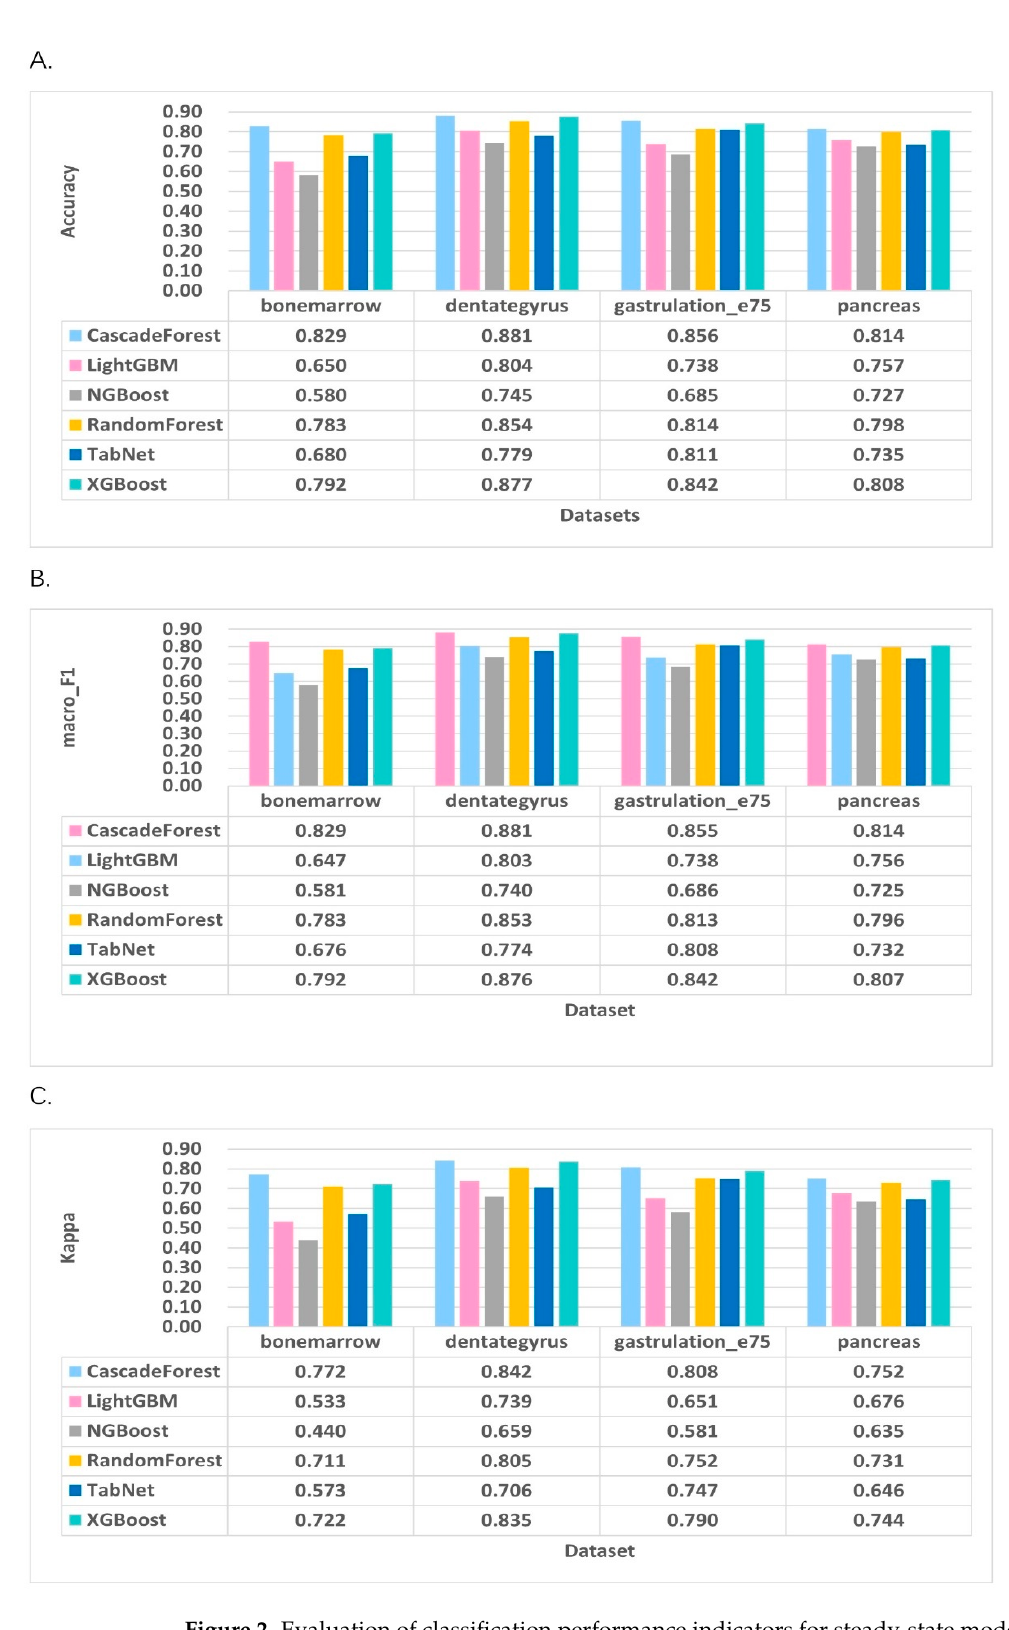
Figure 2. Evaluation of classification performance indicators for steady-state model RNA velocity prediction. ( A ) Accuracy of the classifiers. ( B ) Macro_F1 of the classifiers. ( C ) Kappa coefficients of the classifiers.